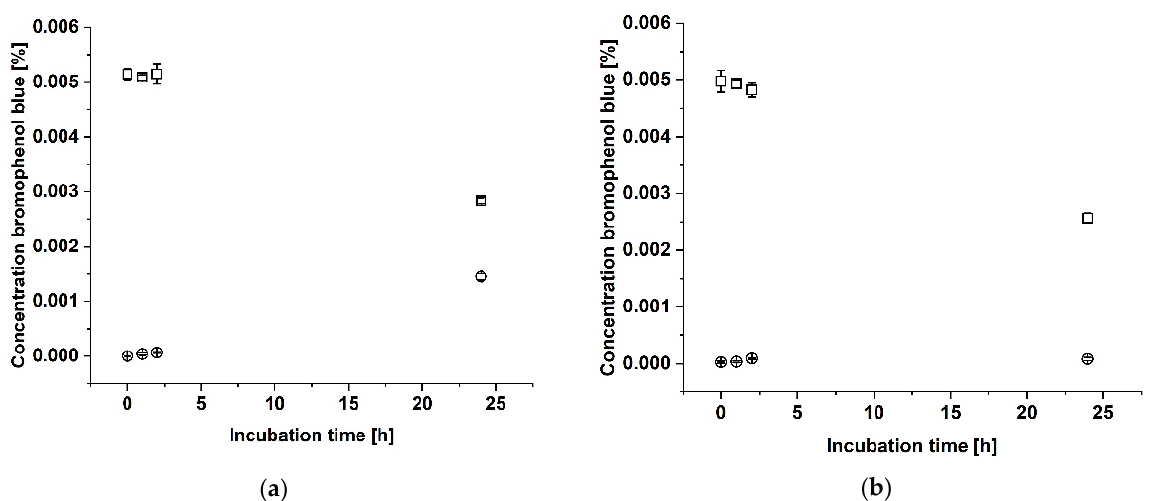
Figure 2. Proof of tightness of the sample holder. The sample holder was fabricated by additive manufacturing from a standard transparent resin. A two-layer collagen laminate consisting of Collagen Solutions and Atelocollagen was placed in the sample holder. The tightness of the sample holder was demonstrated by analyzing the diffusion of bromophenol blue from the upper cavity (squares) into the lower cavity (dots). ( a ) Concentration of bromophenol blue in a setup with a collagen laminate. ( b ) Concentration of bromophenol blue in a setup with a collagen laminate supported by a layer of